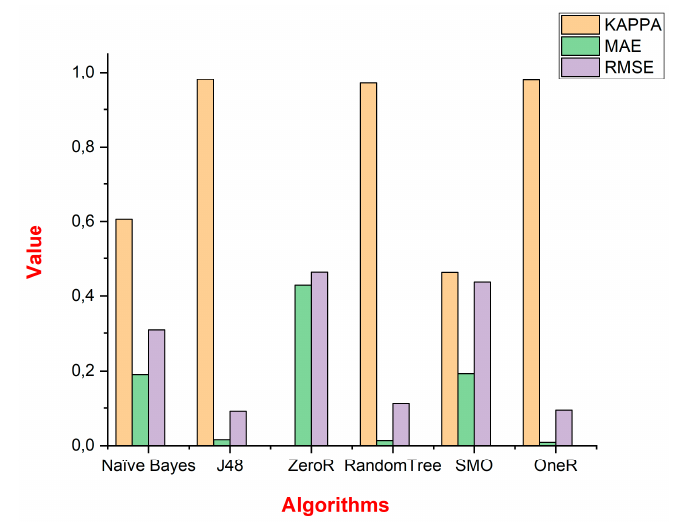
Figure 14. KAPPA Statistics and error rate values.